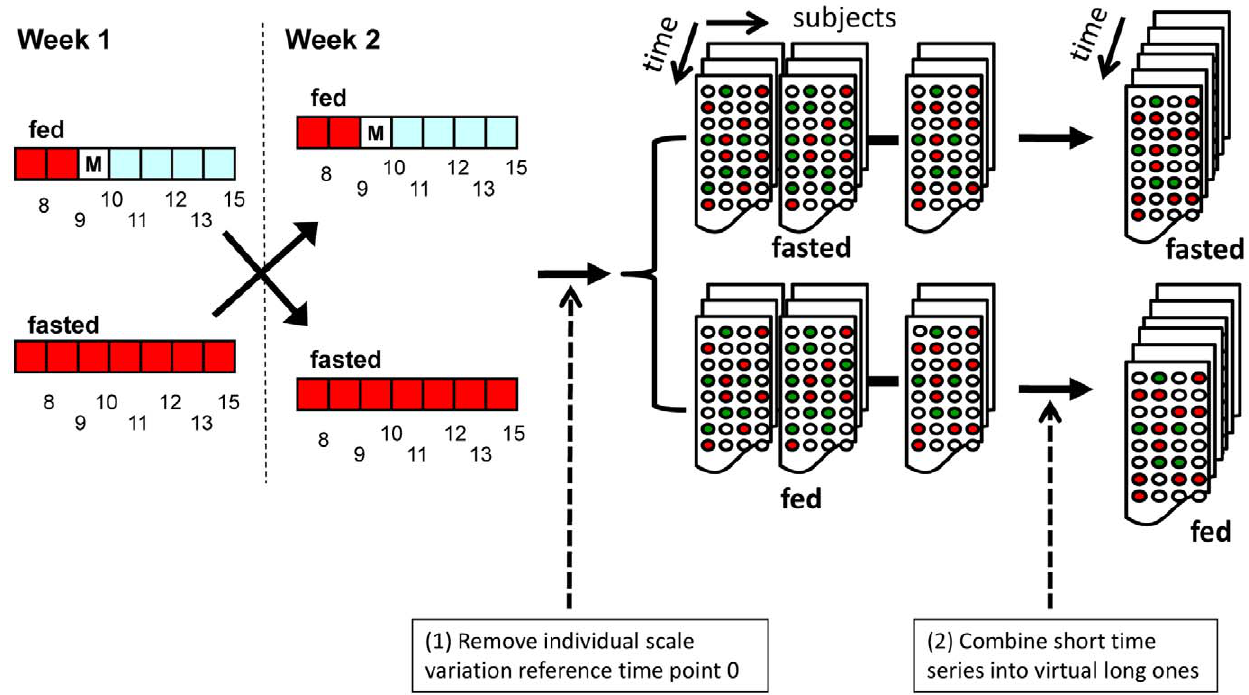
Figure 2. Experimental design and data processing scheme. Forty healthy volunteers were recruited to participate in the study and randomized to a treatment arm (either fasted or fed). To minimize individual scale differences, every participant’s gene expression profile after the first time point was referenced (re-ratioed) to their corresponding expression profile at time point 0. The re-referenced gene expression values from time point 1 to 6 in the figure represent the expression data used herein as virtual long time series.